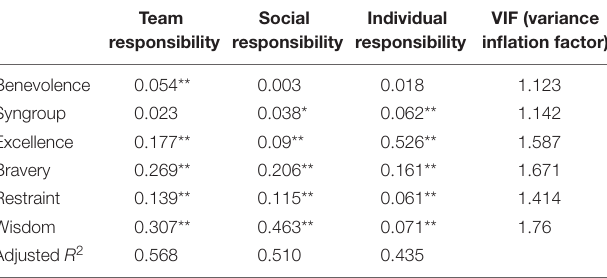
TABLE 11 | Linear regression analysis of positive psychology to sense of responsibility. Team